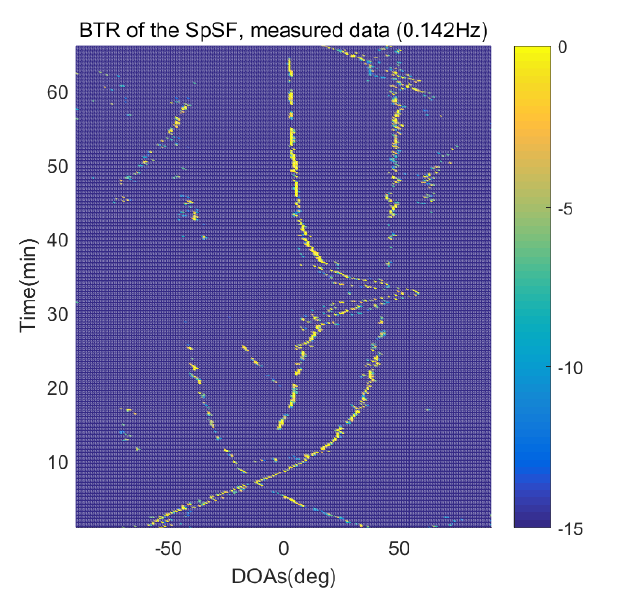
Figure 16. Bearing time records of the SpSF: 66 min, signal frequency = 0.142 Hz.